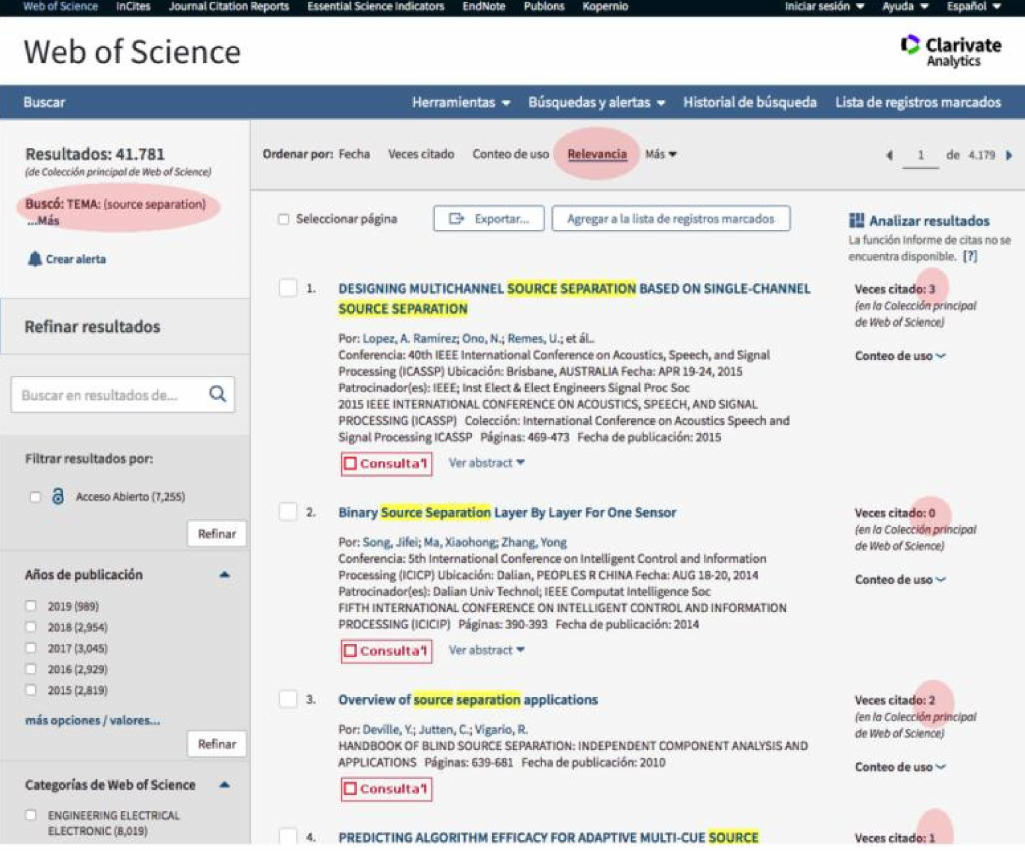
Figure 11. Same search as in Figure 10 with relevance ranking but without using the number of